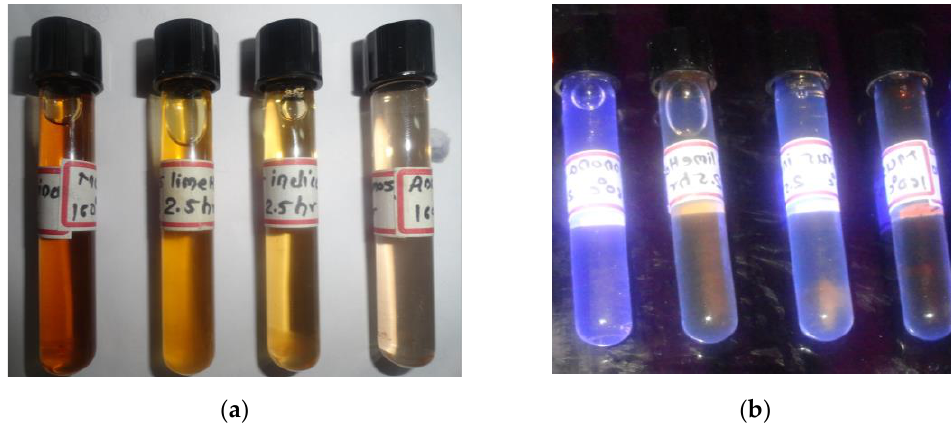
Figure 1. ( a ) Synthesized CDs solutions from different fruit peels from left to right— Annona squamosa (L.), Citrus indica (L.), Citrus limetta (L.), and Musa acuminata (L.); ( b ) CDs solutions under UV-transilluminator.